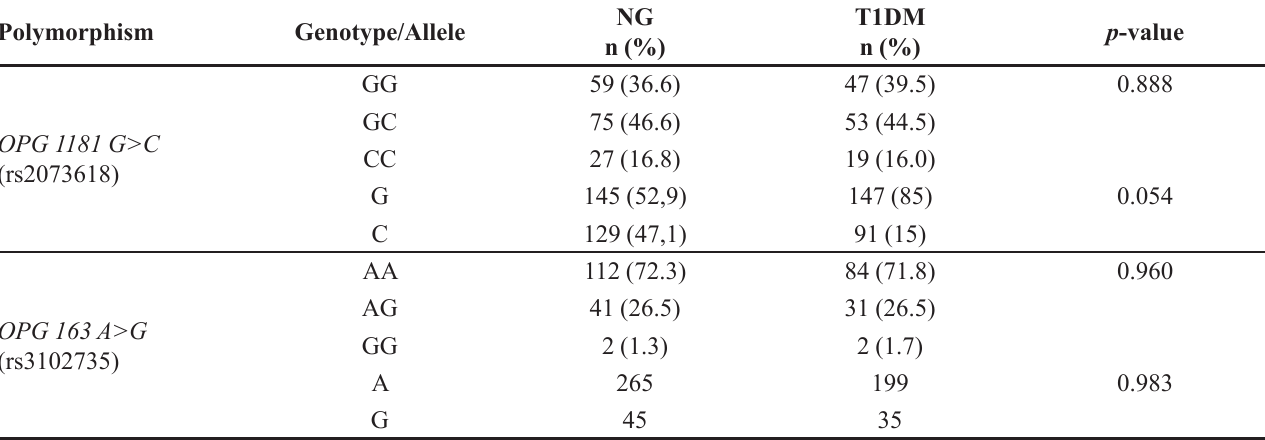
NG, normoglycemic; T1DM, type 1 Diabetes mellitus